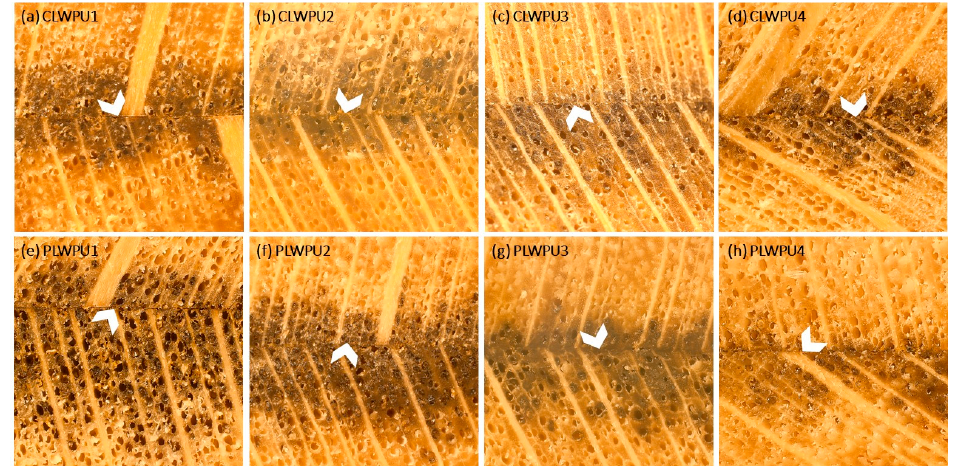
Figure 6. Light microscopy images of adhesive penetration: ( a – d ) LWPU1-4 was made with a NCO/OH ratio from 0.5:1 to 2:1; ( e – h ) PLWPU1-4 was made with a NCO/OH ratio from 0.5:1 to 2:1. Arrow heads are showing the bondlines.